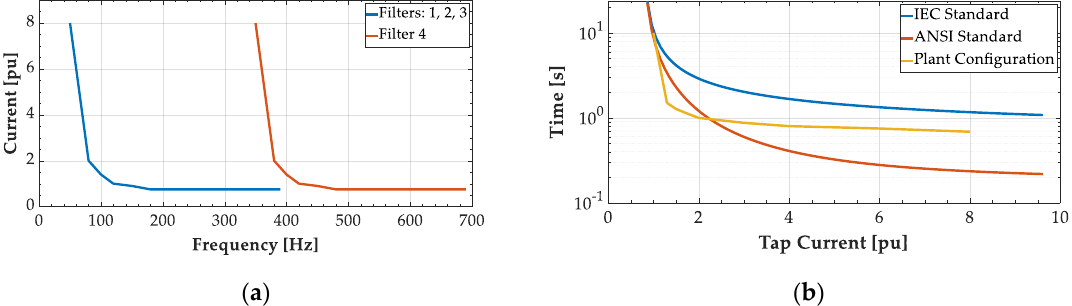
Figure 7. Trip curve of the relay used in filter 3: ( a ) Frequency response; ( b ) time-current curve.